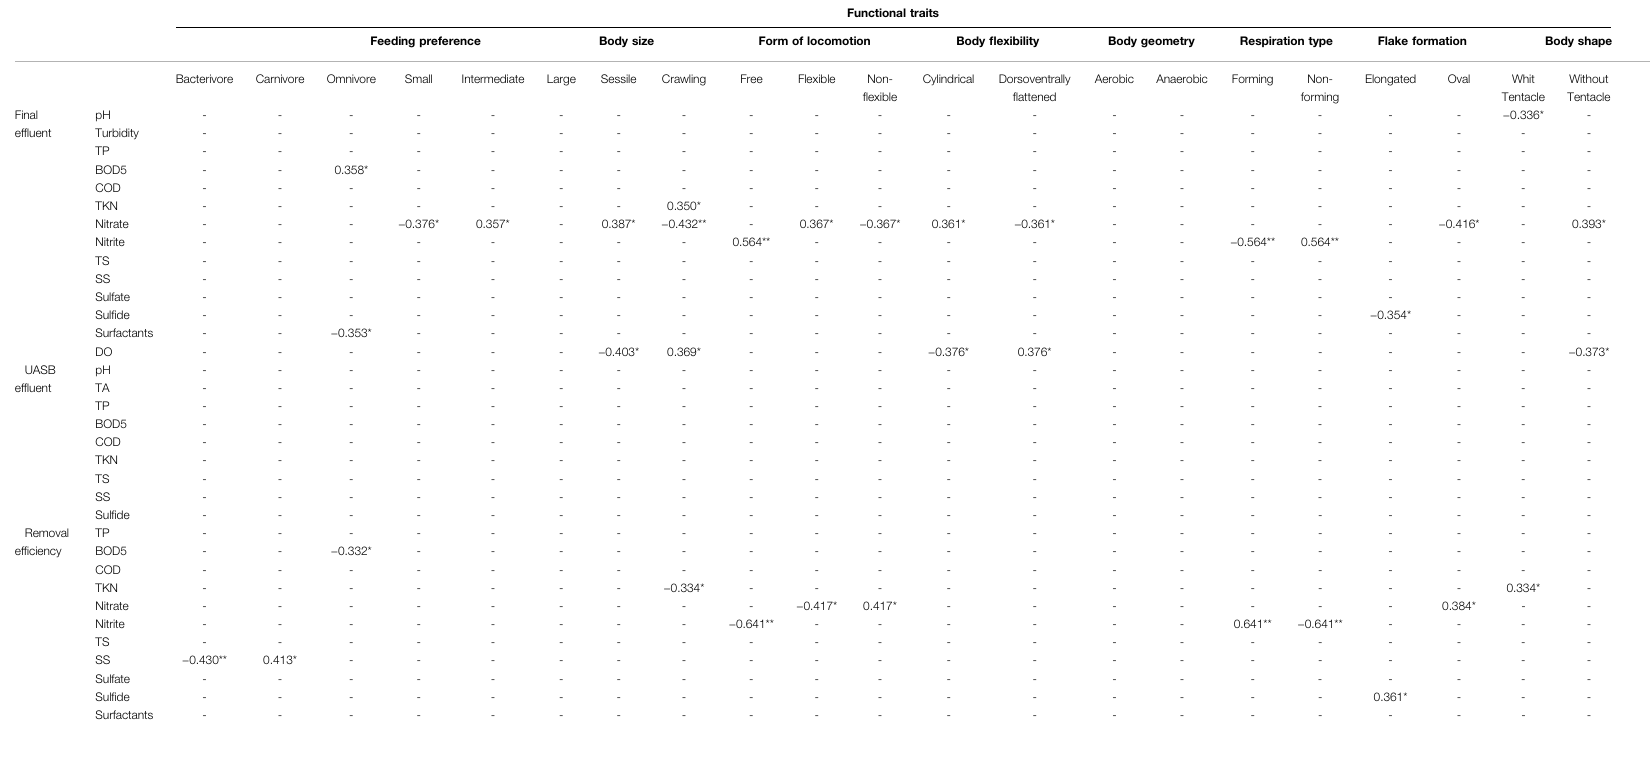
TABLE 2 | Correlation between the functional traits attributed to the ciliate community in a WWTP in Brazil and environmental data. ** p < 0.01 (signi fi cant correlation), * p < 0.05 (signi fi cant correlation).